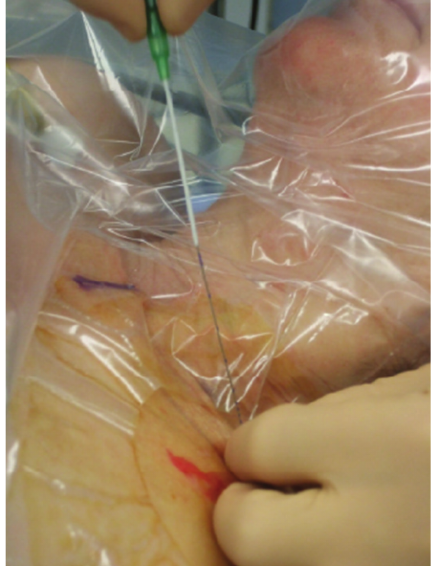
Figure 5: Cannula removal leaving the catheter in place.